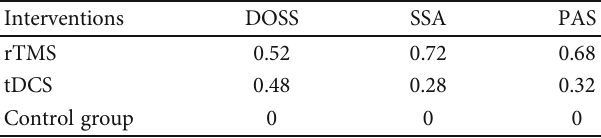
Figure 8: The network relationship of e ffi cacy comparison of di ff erent NIBS. Table 3: Best probability ranking of di ff erent